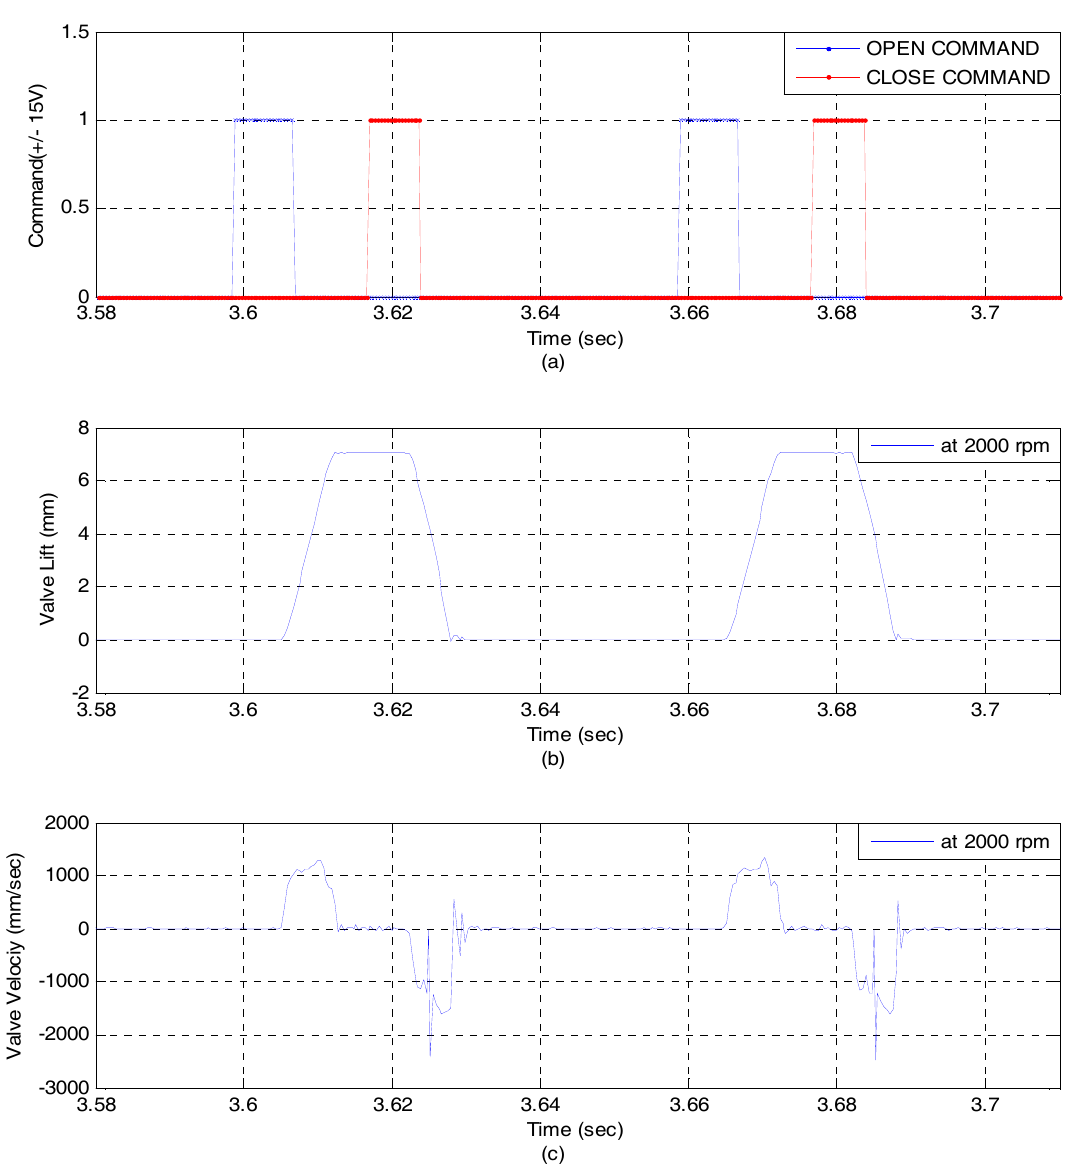
Figure 12. Valve response at 2000 rpm and 100 bar (Open loop): ( a ) Open/Close command; ( b ) Valve lift profile; ( c ) Valve velocity profile.